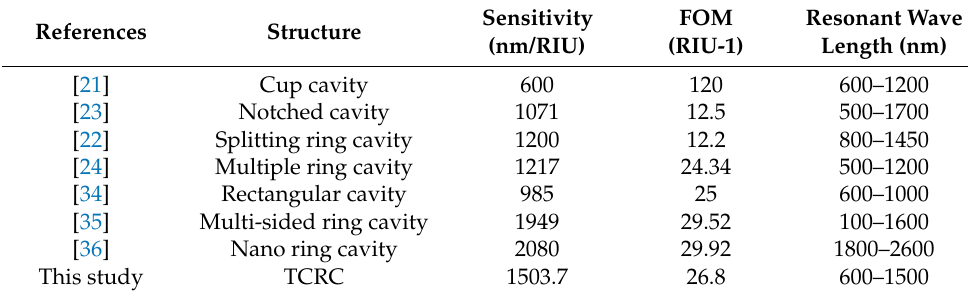
Table 1. The RI sensitivity reported in references.